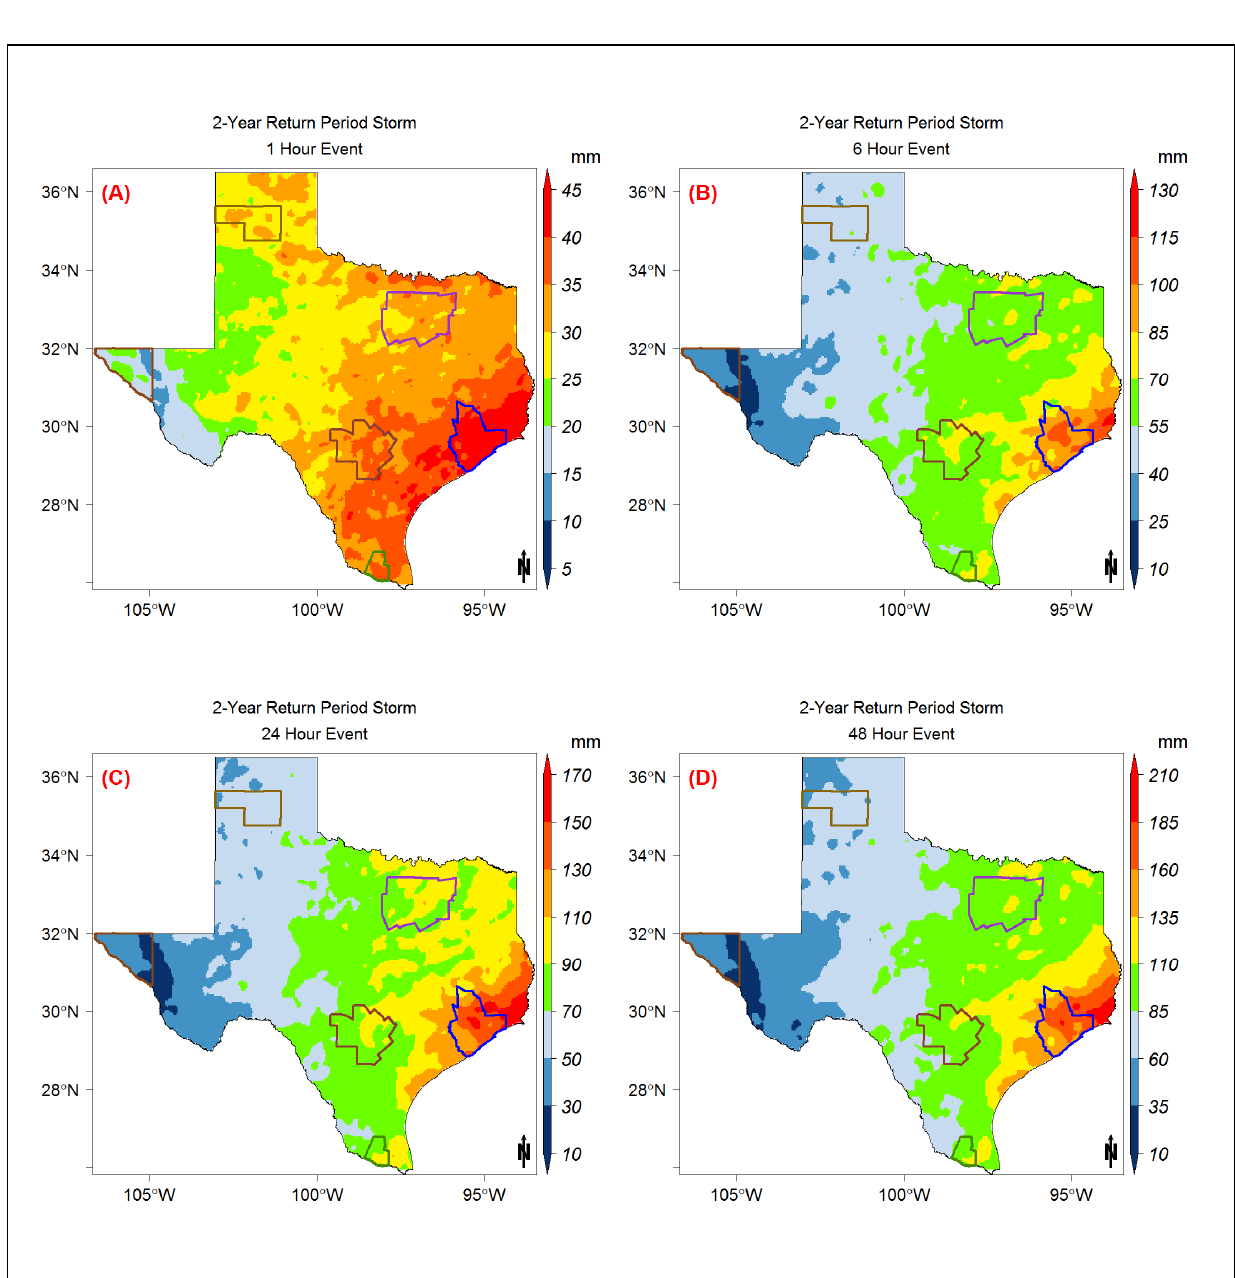
Figure A4. The 2-year return period storm event map modeled using the Gumbel model distribution for the ( A ) 1-h, ( B ) 6-h, (C) 24-h, and ( D ) 48-h storm durations.